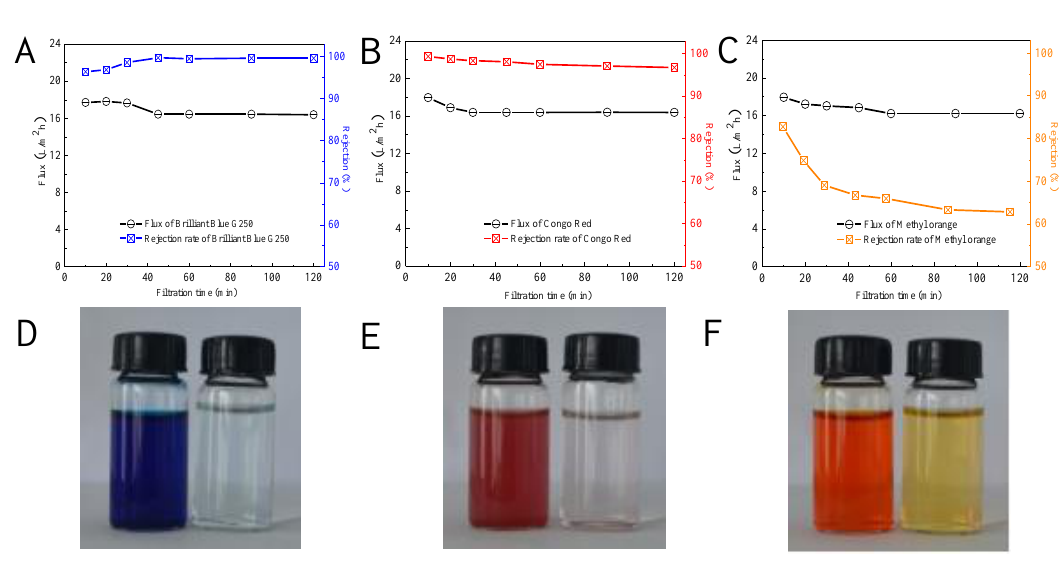
Figure 8. The effect of NaAlg concentration on the flux and removal rate of Cd 2+ .